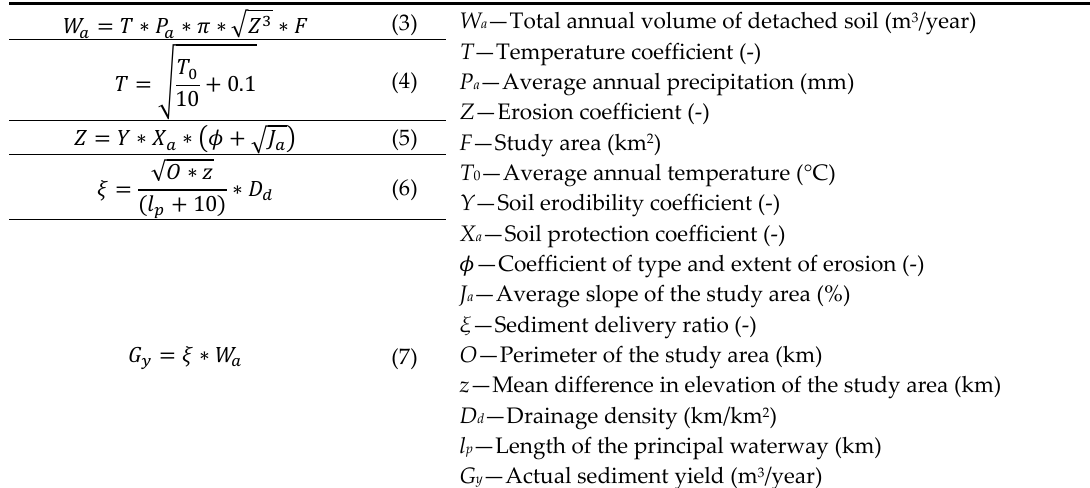
Table 3. Erosion Potential Method equations